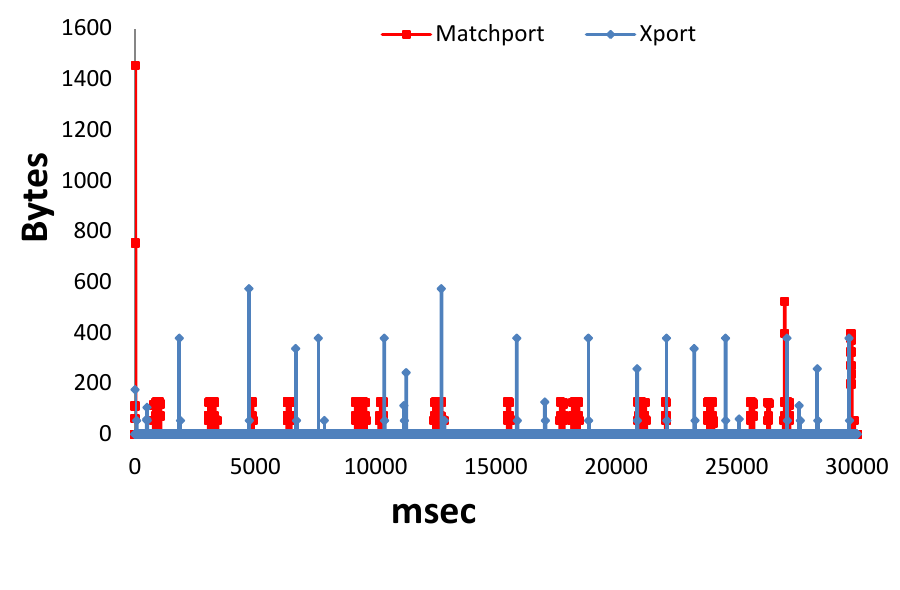
Figure 16. Bytes received per millisecond in active